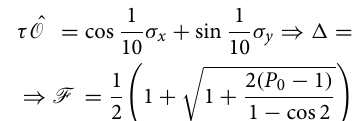
Figure 5. Histograms for the results of 40 independent experiments. with τ and p = 1.5 / r . ( a ) Histogram for the probability to obtain m = 0 . ( b ) Histogram for the fidelity between the agent and the nearest eigenvector using Eq.